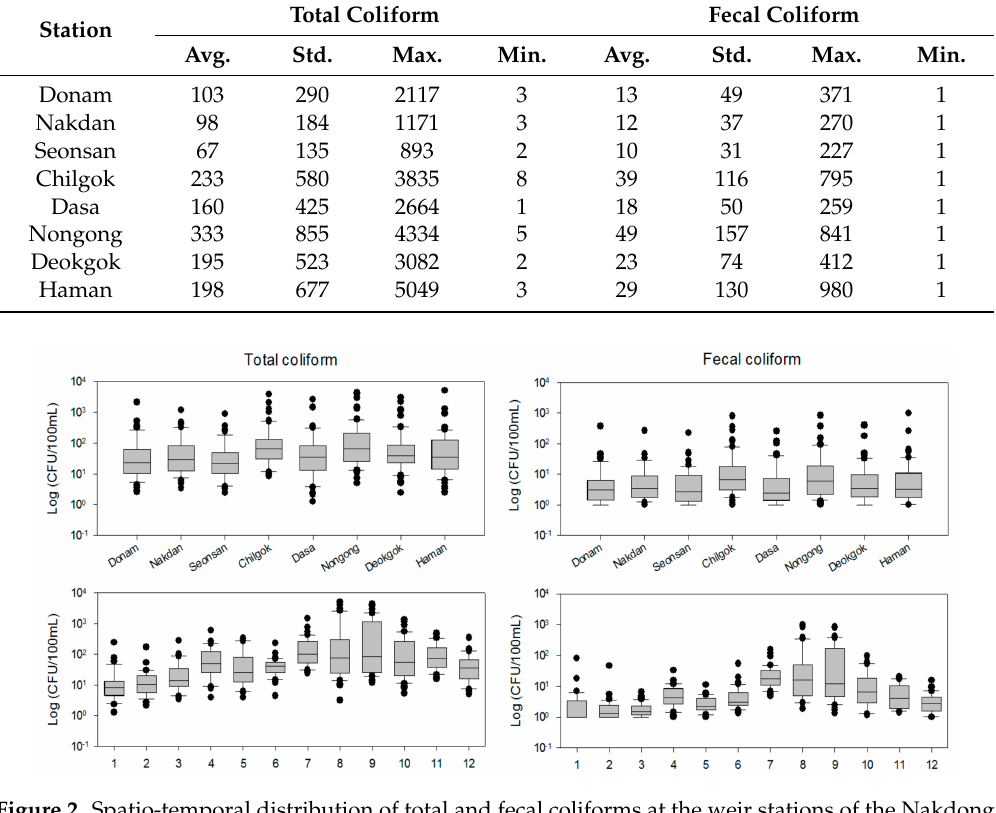
Figure 2. Spatio-temporal distribution of total and fecal coliforms at the weir stations of the Nakdong River. The x -axes of the bottom plots represent